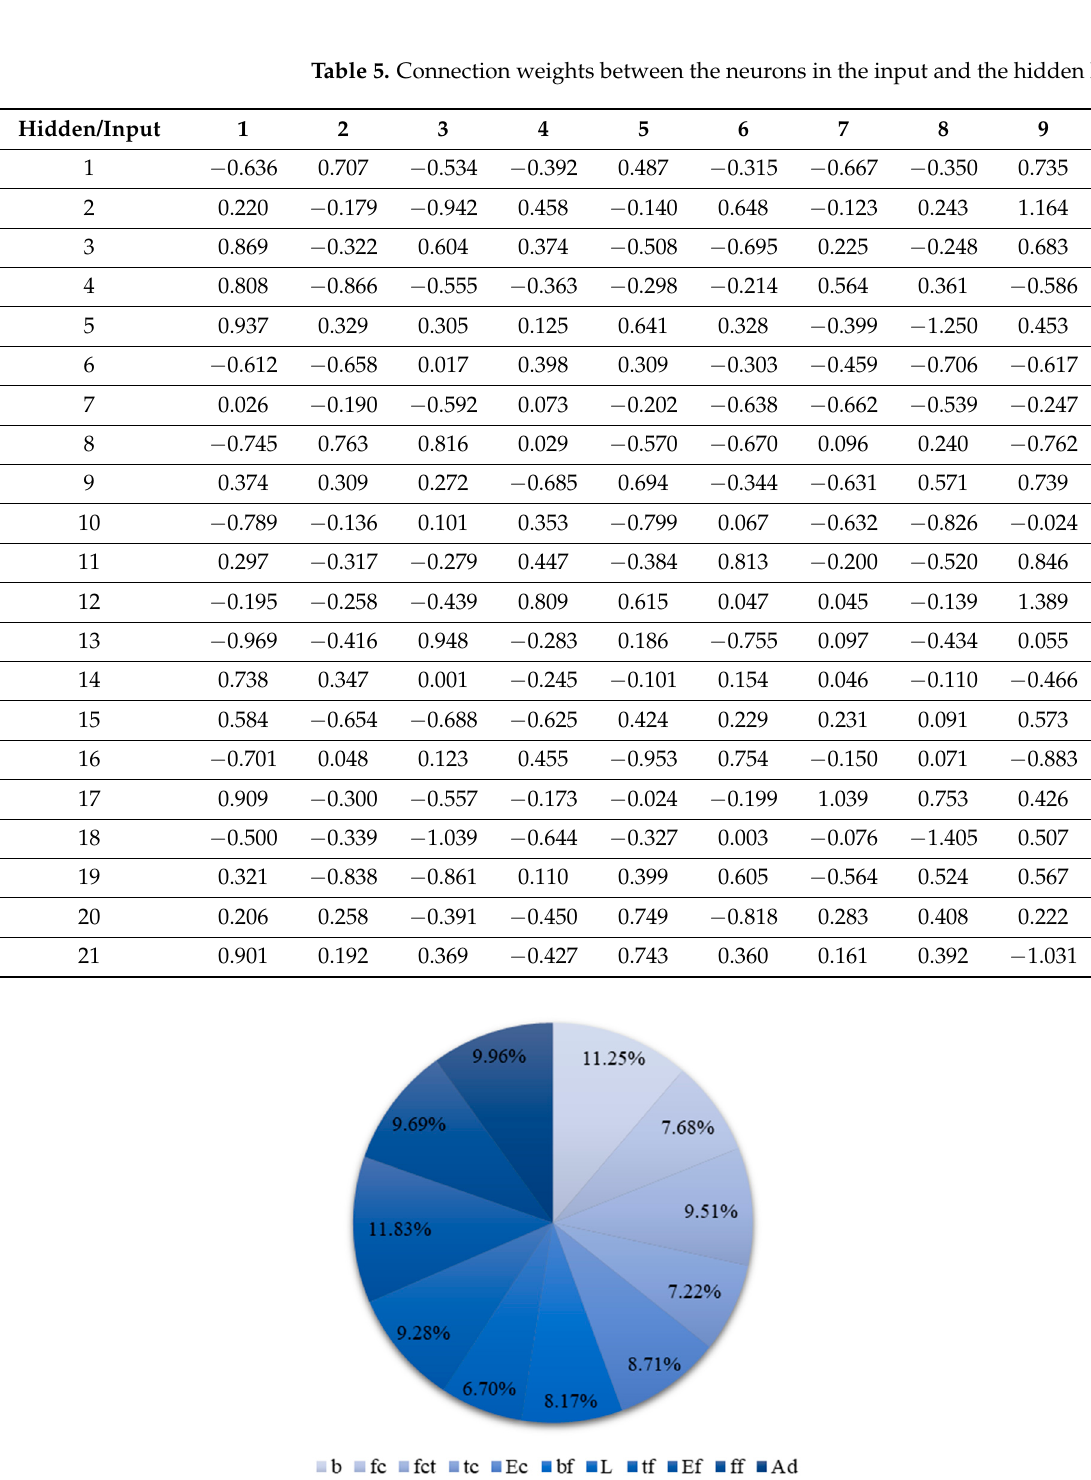
Table 5. Connection weights between the neurons in the input and the hidden layer.